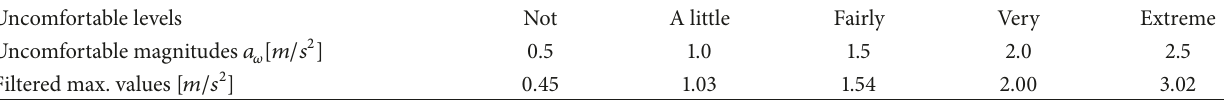
Table 4: Maximum lateral acceleration obtained in the real experiment using speed